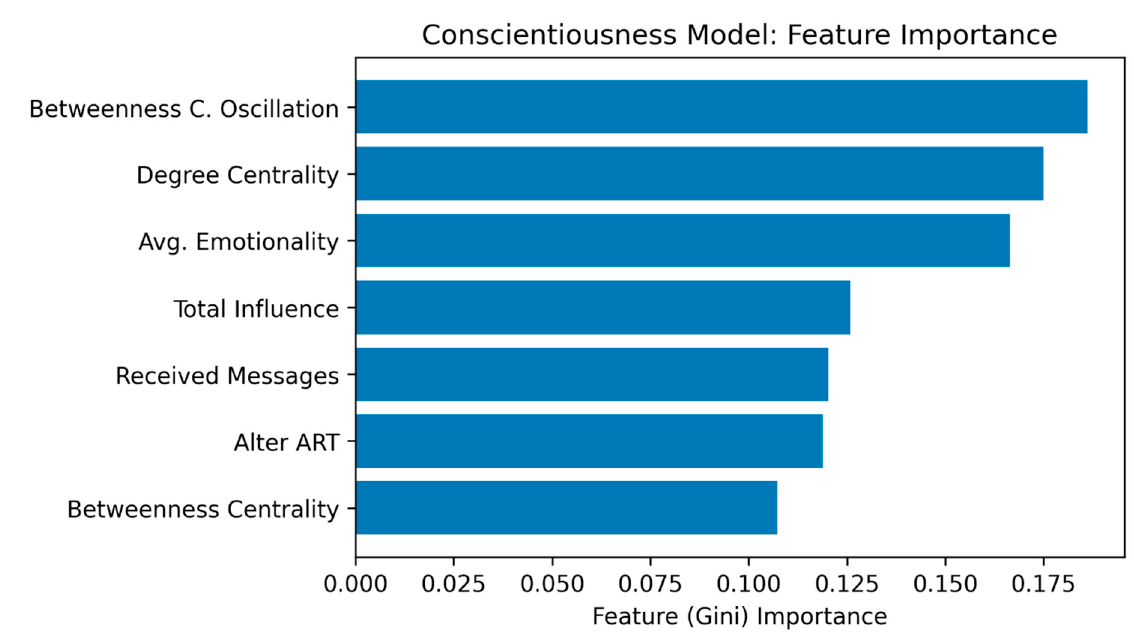
Figure 3. Feature Importance of Conscientiousness Model.